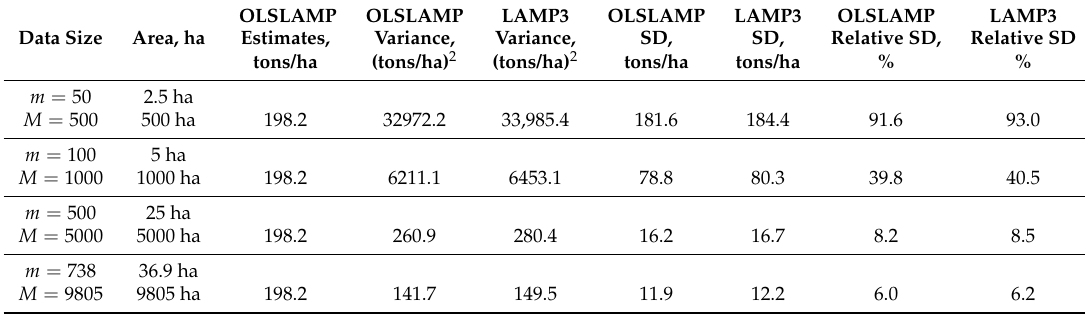
Table A1. Average estimated surrogate plot aboveground biomass (AGB-LAMP), and variance and standard deviation (SD) of OLSLAMP and LAMP3 methods calculated using four different sets of field and surrogate plots. Field plots ( m ): 50, 100, 500. Surrogate plots ( M ): 500, 1000, 5000. The last set has all field plots (738) and surrogate plots (9805). All sets, excluding the full set, have been ran 100 times and an average of sample results have been added to table.